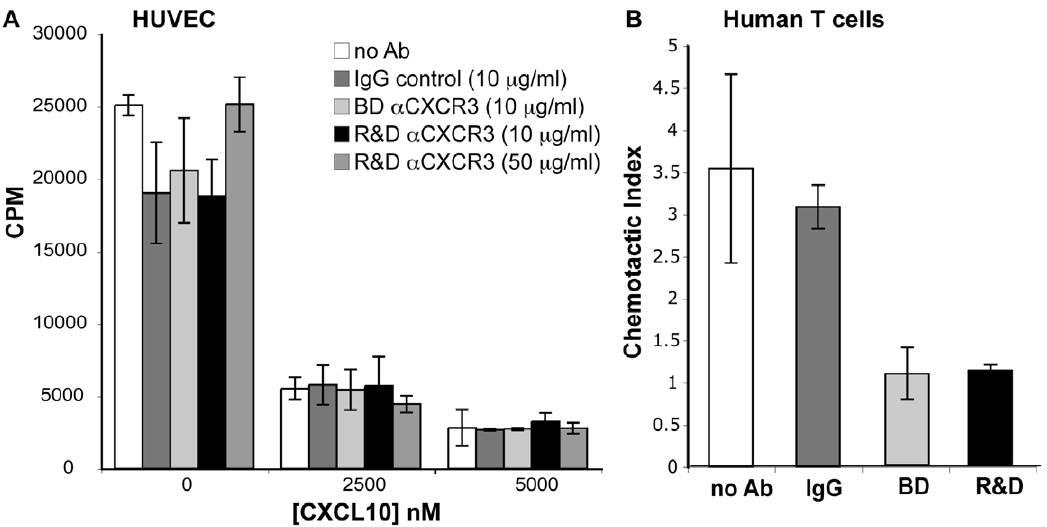
Figure 7. Neutralization of CXCR3 does not diminish CXCL10’s anti-proliferative effect. A) HUVEC were plated in 96 well plates with bFGF. 24 hr after plating, new media with CXCL10 and anti-CXCR3 antibody from BD Bioscience (10 m g/ml) or R&D (10 or 50 m g/ml), or an isotype control IgG (10 m g/ml). 3 H-thymidine incorporation was assessed for the final 18 hr of incubation. Representative data of two experiments are shown, each performed in triplicate, data are mean 6 SD. B) BD Bioscience and R&D neutralizing anti-CXCR3 antibodies block the ability of CXCL10 to induce chemotaxis of human T cells. 100 ng/ml CXCL10 was placed in the bottom well of Neuropore chemotaxis chambers. Human T cells were pre- incubated with 10 m g/ml antibody, and were added on top of the Neuroprobe membrane and allowed to migrate for 2 hours. Representative data from two experiments are shown, each performed in duplicate, data are mean 6 SD.